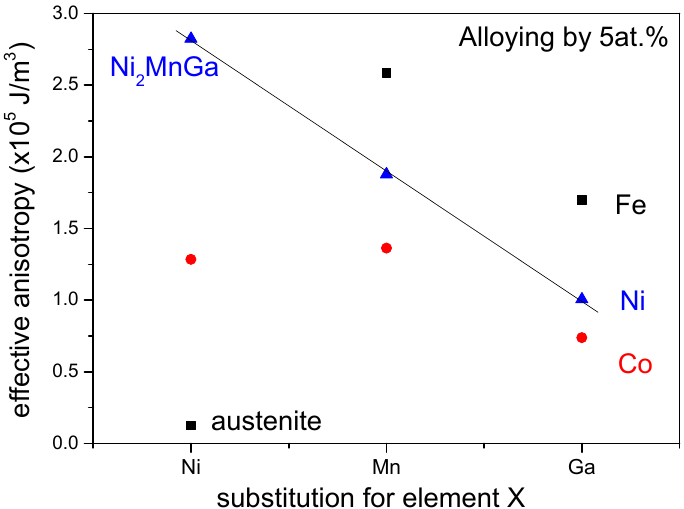
Figure 3. Effective magnetocrystalline anisotropy of Ni 2 MnGa substituted by 5 at. % of Fe, Co and Ni on different position of the compound, i.e., for Ni, Mn, and Ga as marked. The alloy Ni 45 Fe 5 Mn 25 Ga 25 is in austenite state and the anisotropy is the order of magnitude lower and comparable to stoichiometric Ni 2 MnGa austenite (see text). The line is just a guide for eyes.